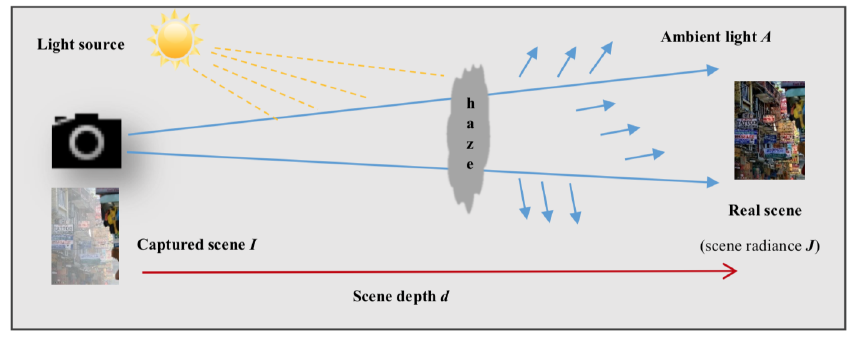
Figure 1. Hazy image degradation